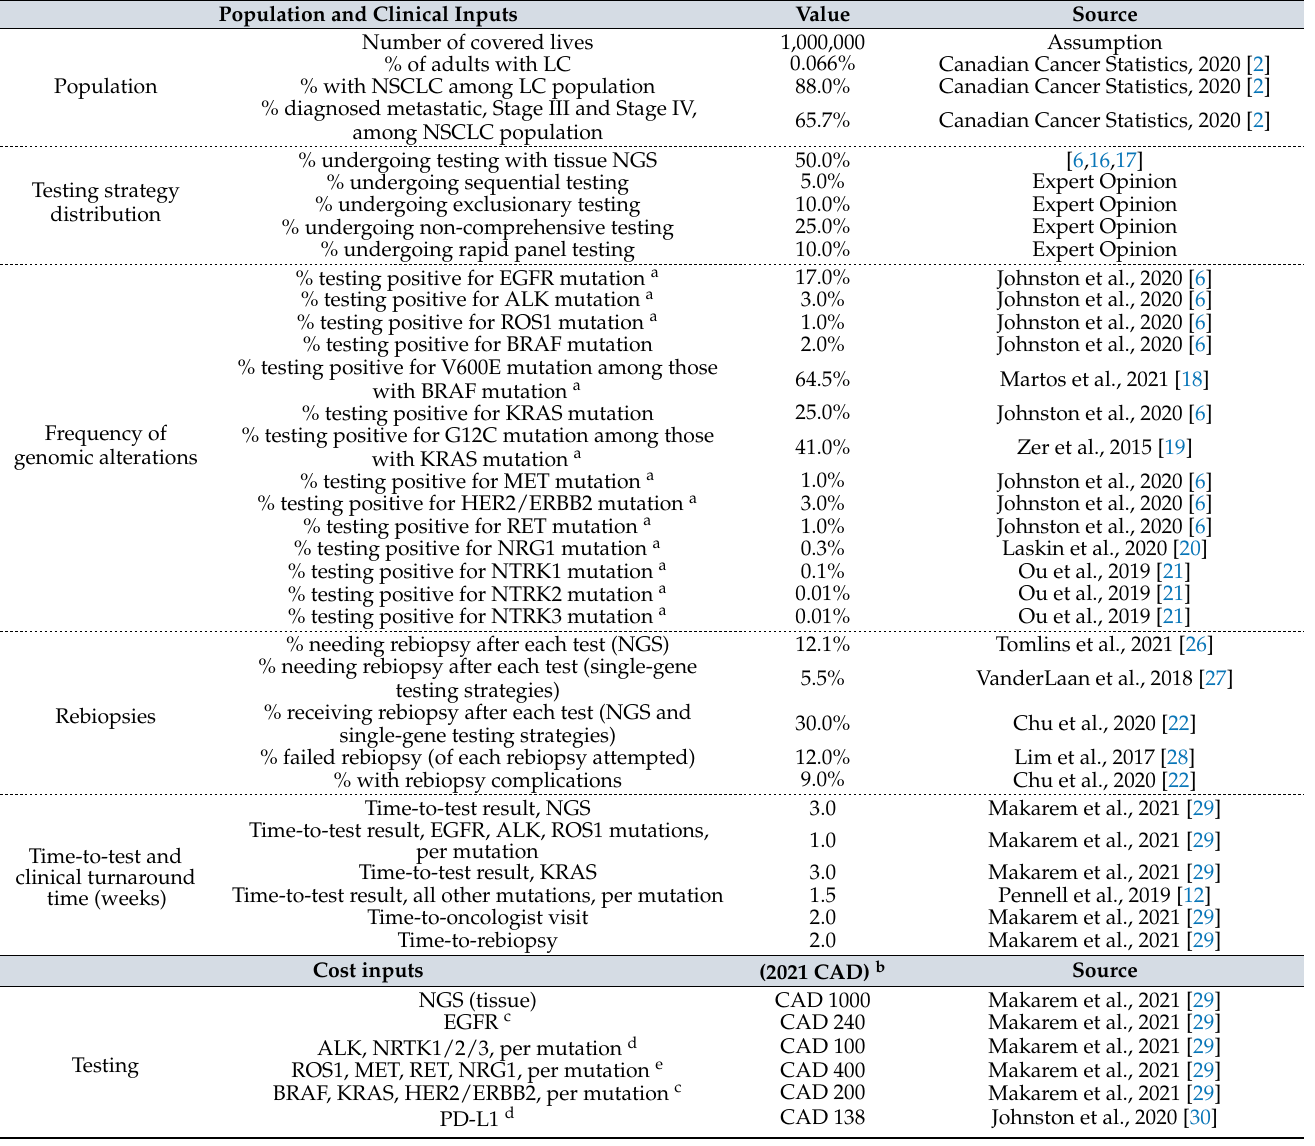
Table 1. Summary of model